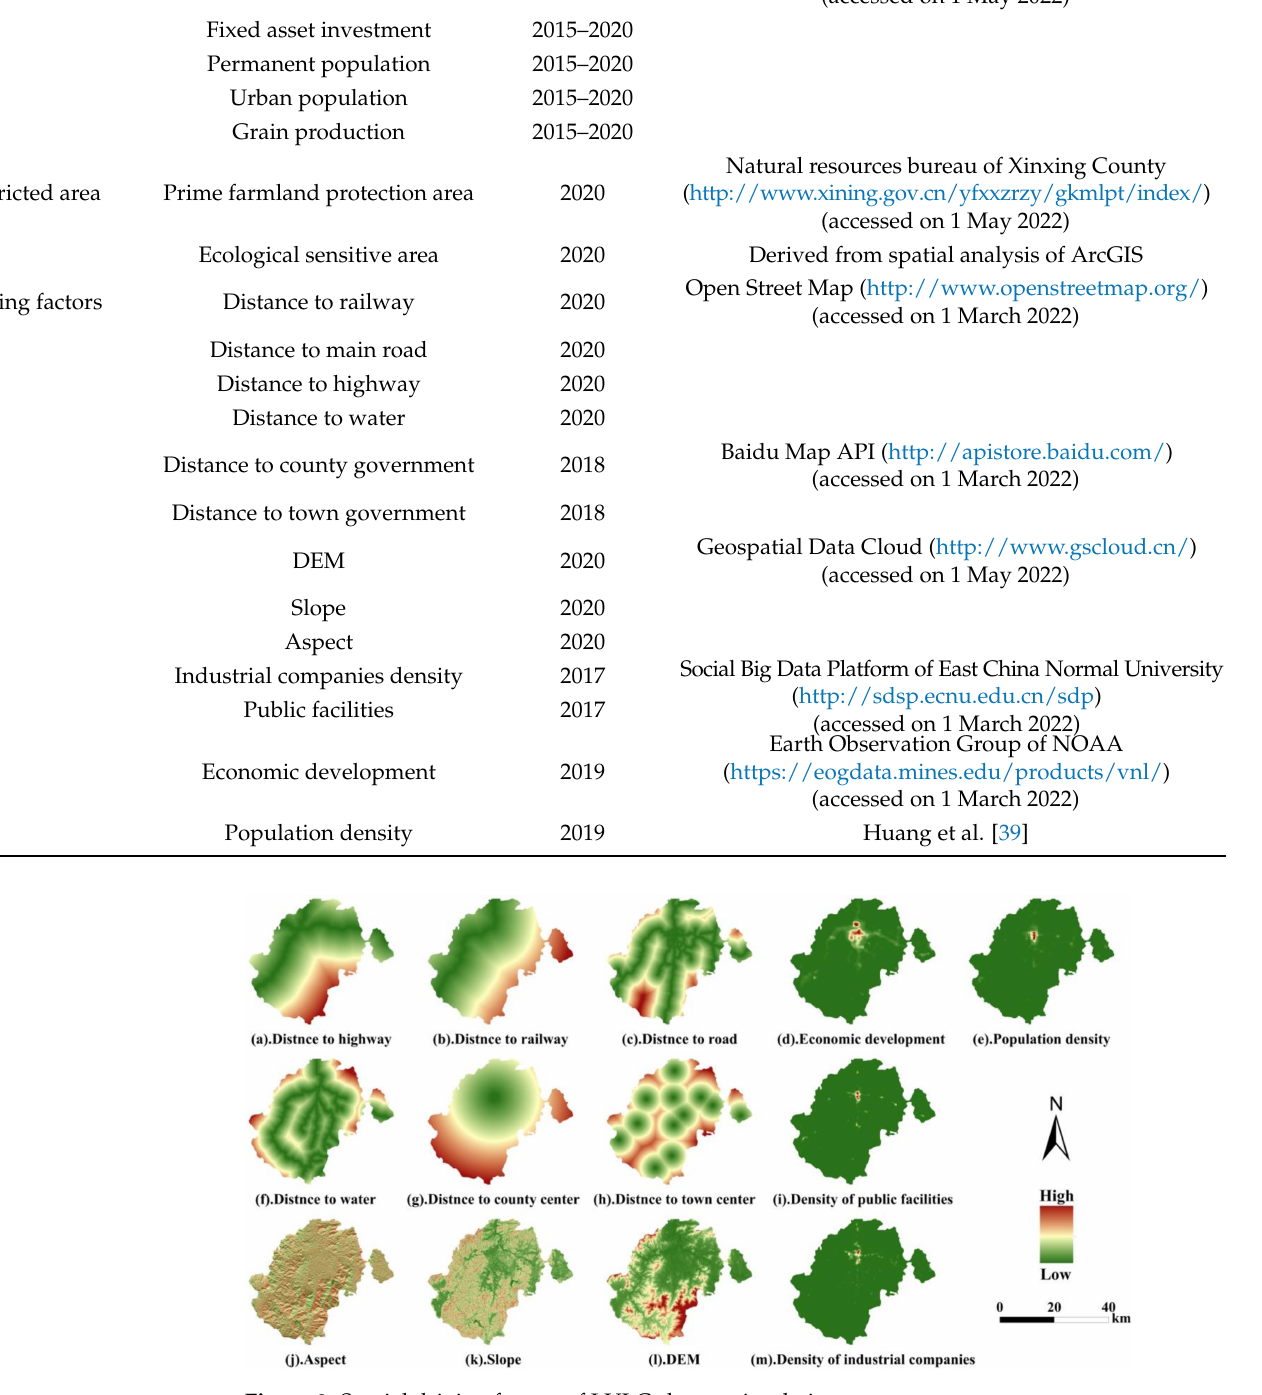
Figure 2. Spatial driving factors of LULC change